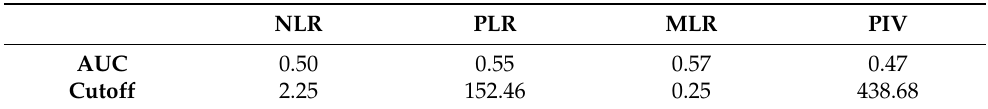
Table 2. Optimal cutoff values of the pre-treatment NLR, PLR, MLR, and PIV based on ROC curve analysis for prediction of 5-year DMFS in the study population.